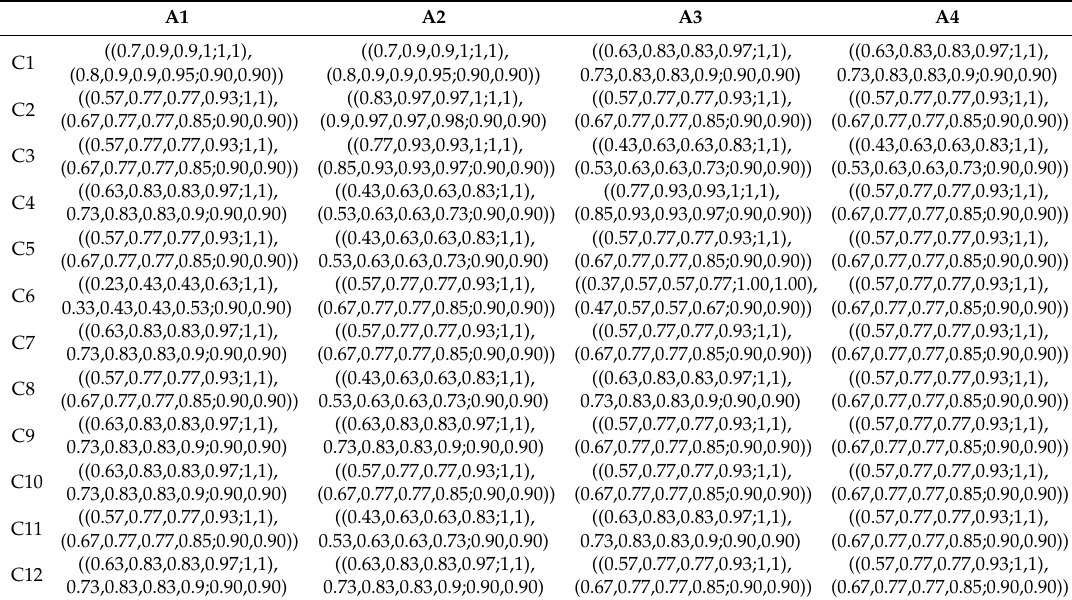
Table A7. Fuzzy decision